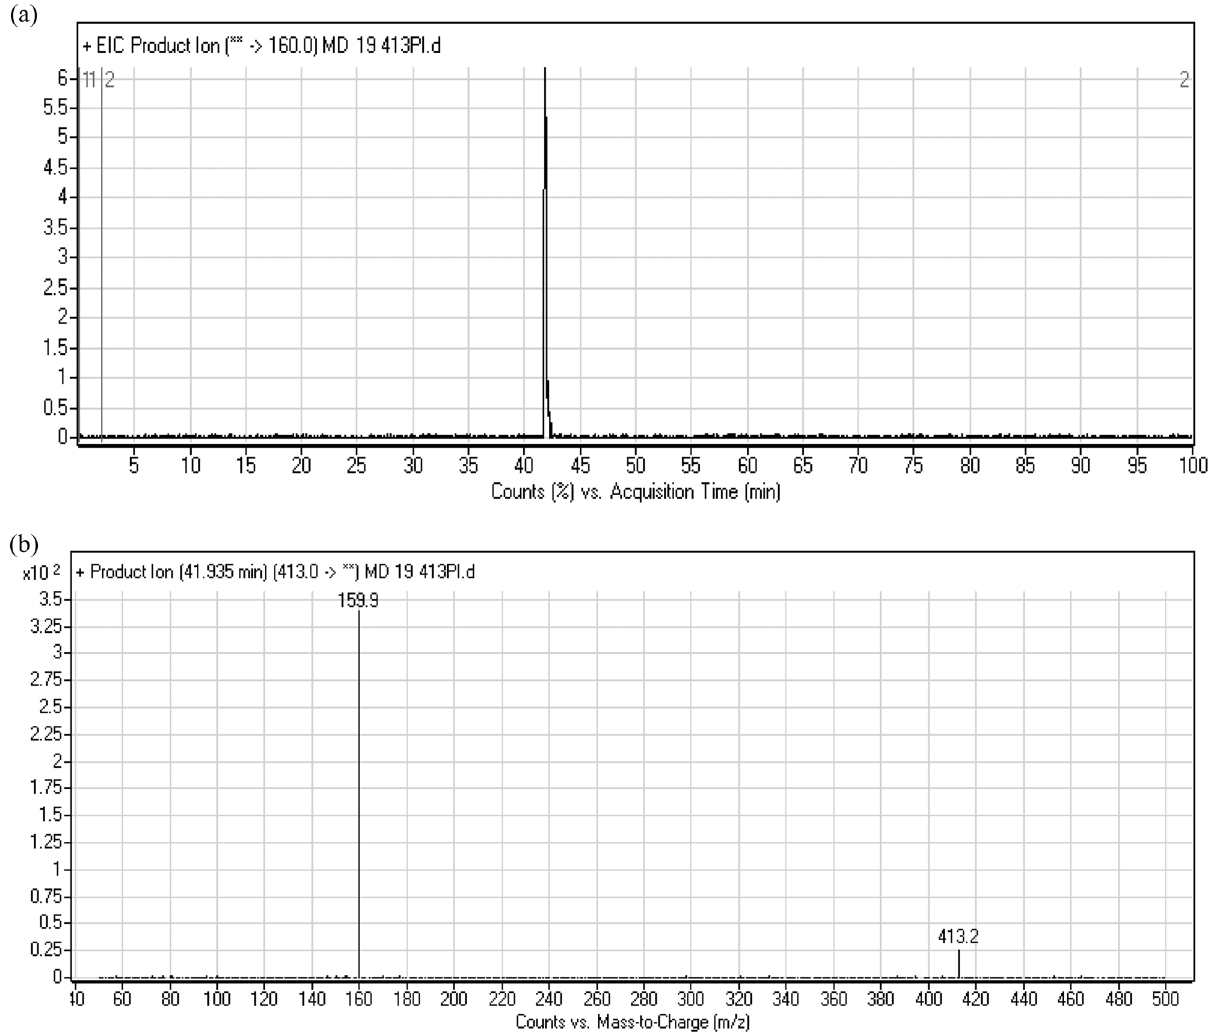
Figure 7: PI chromatogram of M3 showing a chromatographic peak at 41.9 min ( a ) and PI mass spectrum of M3 ( b ) . ( PI fragmentation of M3 at m / z 413 gave one fragment ion at m / z 160 that showed 14 m / z less units, which revealed an O - demethylation metabolic reaction )